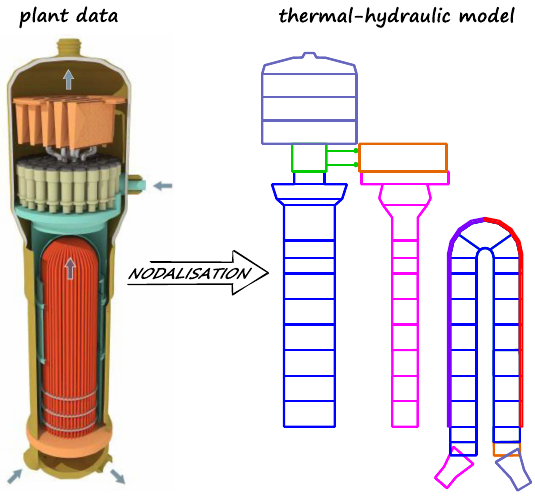
Fig. 1. Example of a steam generator model and nodalisation